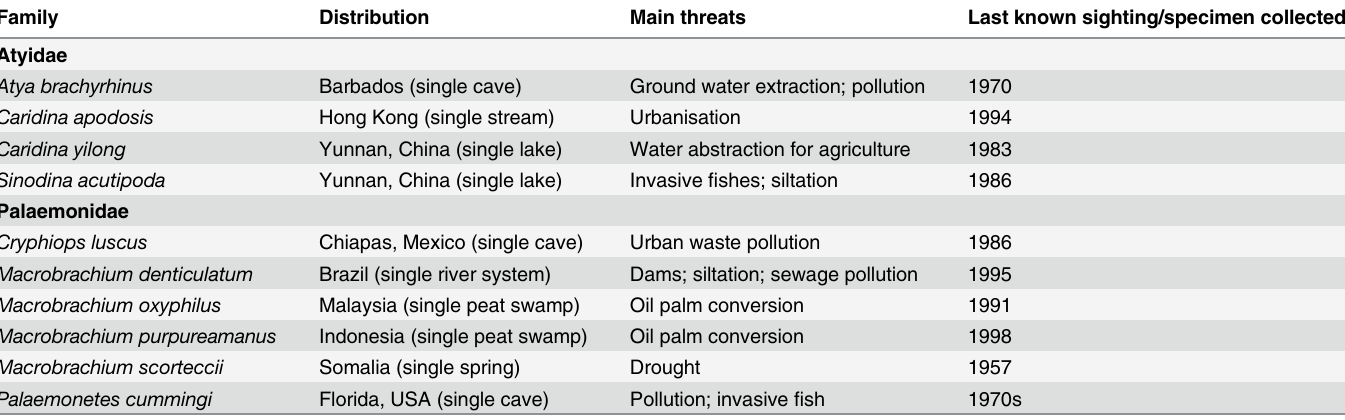
Table 3. Freshwater shrimps currently considered as Critically Endangered (Possibly